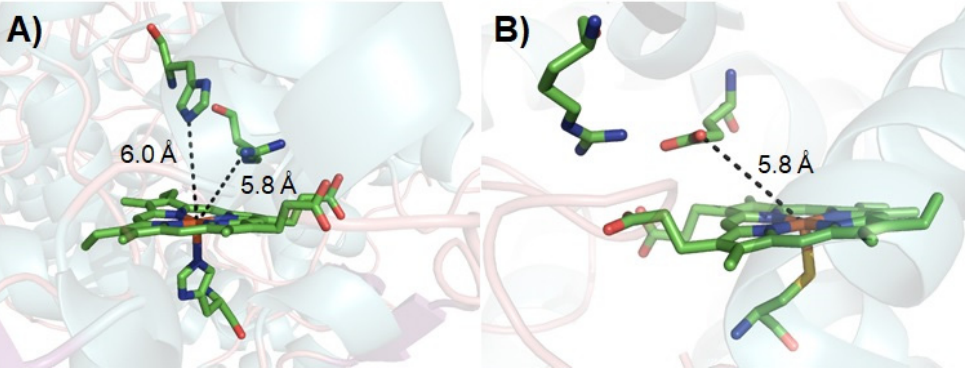
Figure 2. Active site structures of HRP (( A ), PDB ID: 1ATJ) [58] and unspecific peroxygenase (( B ), PDB ID: 2YOR) [59].